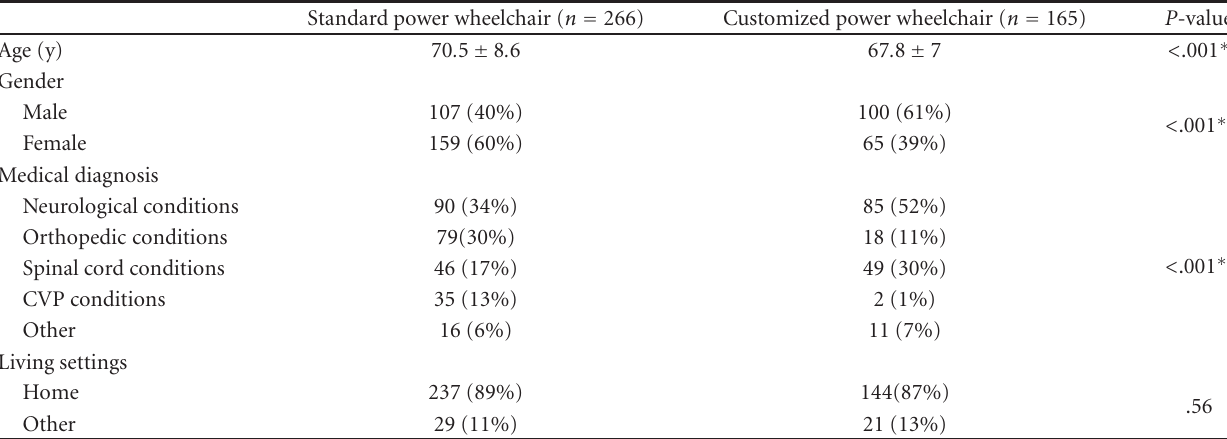
Table 6: Tier 5: Factors associated with use of standard (Group 1 and 2) versus customized (Group 3 and 4) power